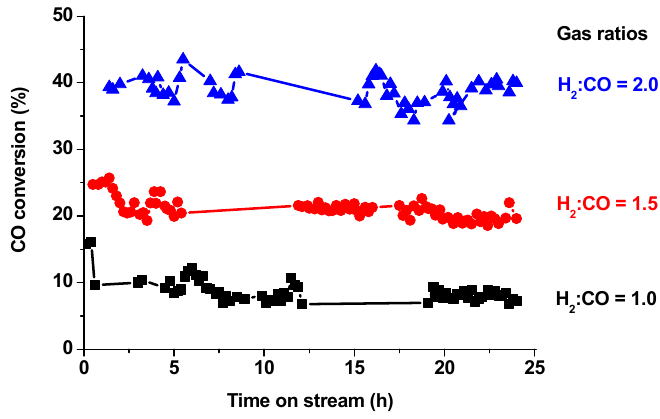
Figure 4. Plots showing the positive influence of H 2 on FTS reaction with TOS using the Co/C catalyst tested at 220 ◦ C, 2 MPa and GHSV of 3600 cm 3 · g − 1 · h − 1 .